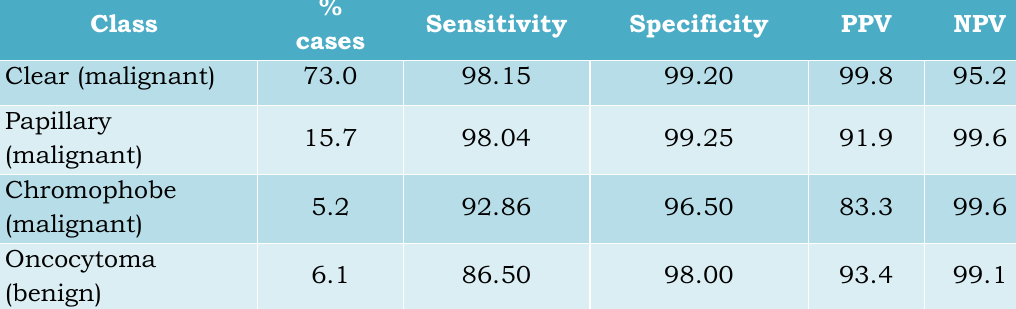
Table 1. Projected performance characteristics of diagnostic.